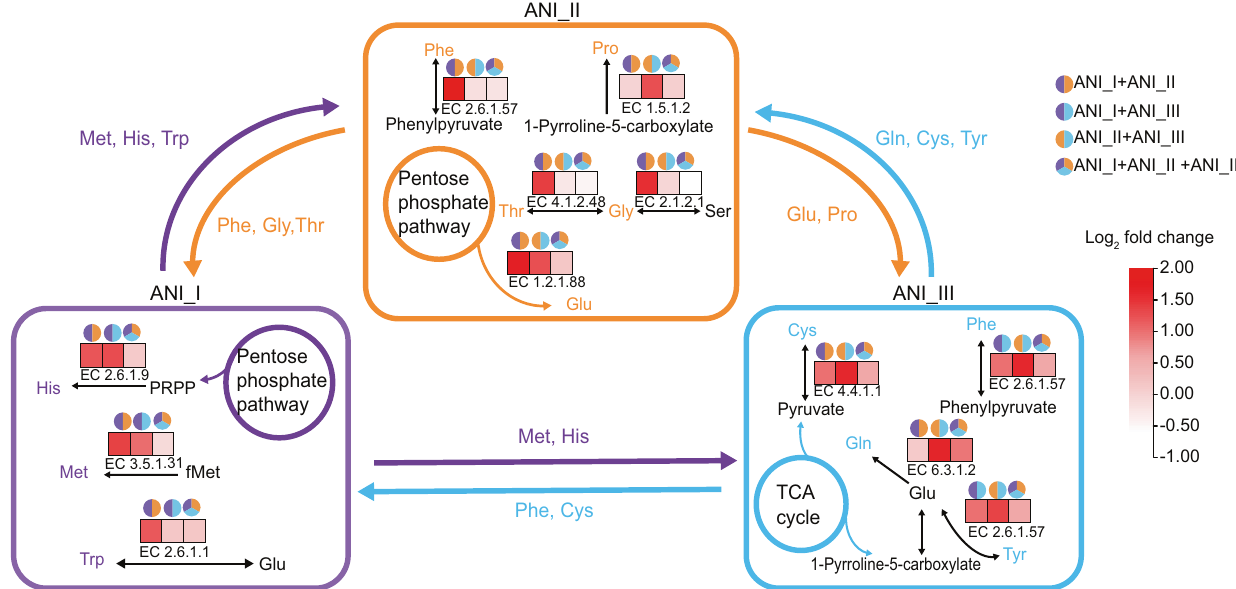
Fig. 5 Construction of metabolic cooperation scheme related to amino acid between three genotypic groups of L. acetotolerans . The transcription of the last gene in the biosynthesis pathway of related amino acid is shown in the frame of different genotypic groups, and the heatmap is shown using the log 2 fold change value of transcriptional data in coculture compared to monoculture. The small pie chart above the heatmap indicates the coculture group (Figs. 4 and 5, Supplementary Fig. 10A – C, Supplementary Table 4). In general, we revealed metabolic cooperation related to amino acids between different conspeci fi c genotypic groups within L. acetotolerans species, which would improve fi tness of L.